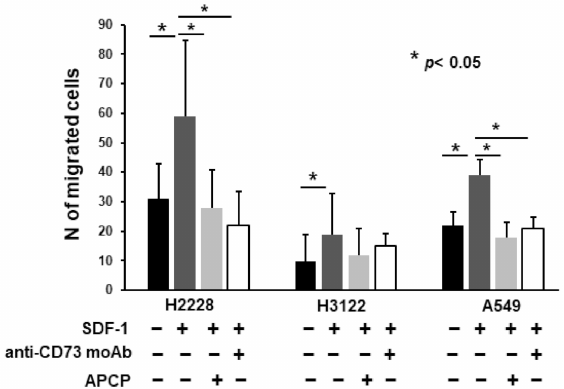
Figure 5. In vitro migration assay ofH2228, H3122 and A549 cell lines. Cells were treated with CD73 inhibitors, moAb anti-CD73 at 20 µ g/mL and APCP at 50 µ M, and chemoattracted by SDF-1 at 50 ng/mL. Data represent the mean number ± SD of migrated cells after treatment relative to the untreated control. Significance was calculated by one- way Anova comparing treated cells vs. positive control. Two experiments were performed for each cell